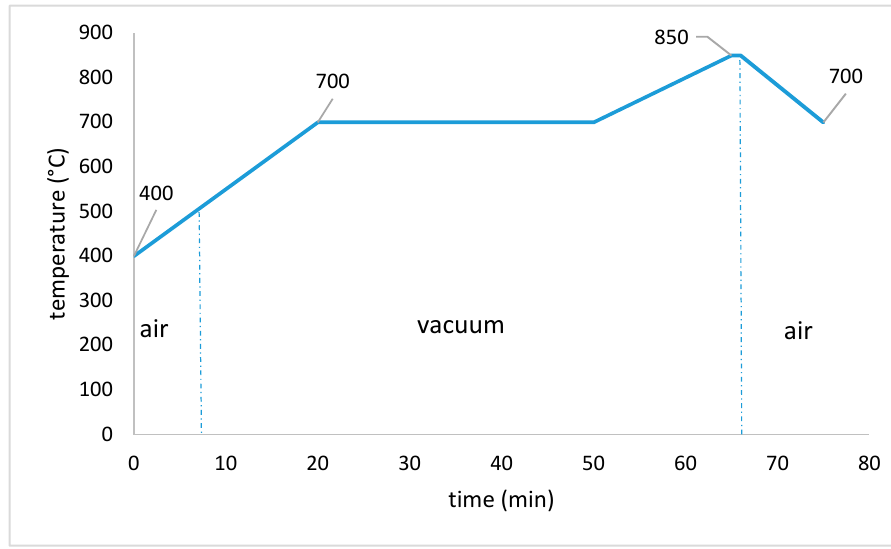
Figure 6. Debinding program E-MP/9.